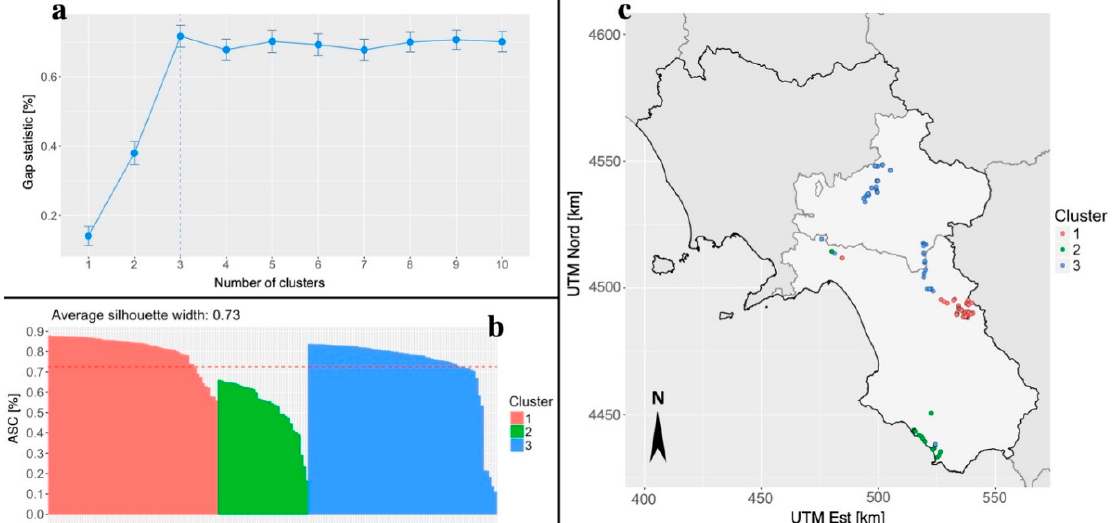
Figure 4. Panel plot for the cluster analysis performed on the first two PCs calculated on the fatty acids dataset. It is reported the number of clusters that maximize the value of the gap statistic ( a ), the individual silhouette of each cluster the average silhouette as a measure of cluster internal accuracy ( b ) and the cluster membership of each sampled tree reported on the geographic basis ( c ). Cluster n° 1 (red color) contains all samples of the CE collection site and samples OIR73 and OIR74; cluster number 2 (green color) contains 32 out of 33 samples of the CM collection site and samples OIR2 and OIR4; cluster number 3 (blue color) contains all samples of the OSE collection site, 44 out of 48 samples of the OIR collection site and sample SM5.